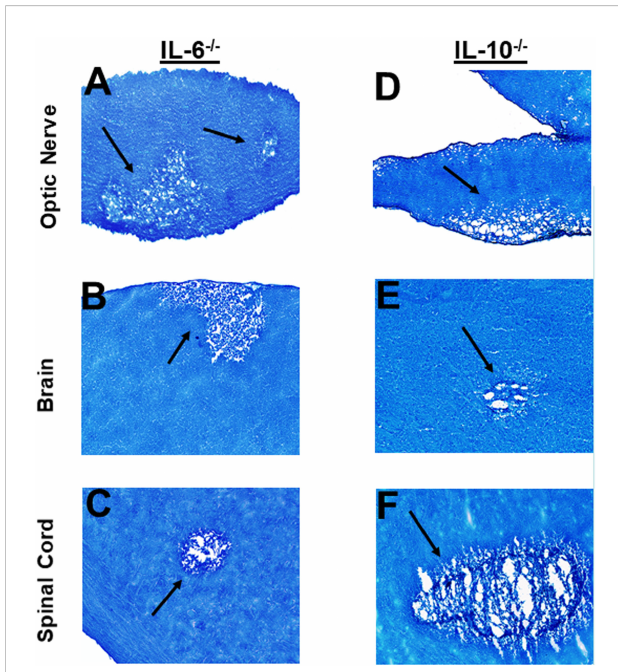
FIGURE 6 Role of IL-6 and IL-10 in HSV-IL-2 induced CNS demyelination. Five female IL-6 -/- (A, B, C) and IL-10 -/- (D, E, F) mice were infected ocularly with 2 X10 5 pfu/eye of HSV-IL-2 virus. On day 14 PI, optic nerves (A, D) , brain (B, E) , and spinal cord (C, F) were collected, fi xed, sectioned, and stained with LFB. Representative photomicrographs are shown. Arrows indicate areas of demyelination. x10 objective lens was used (100x mag.).